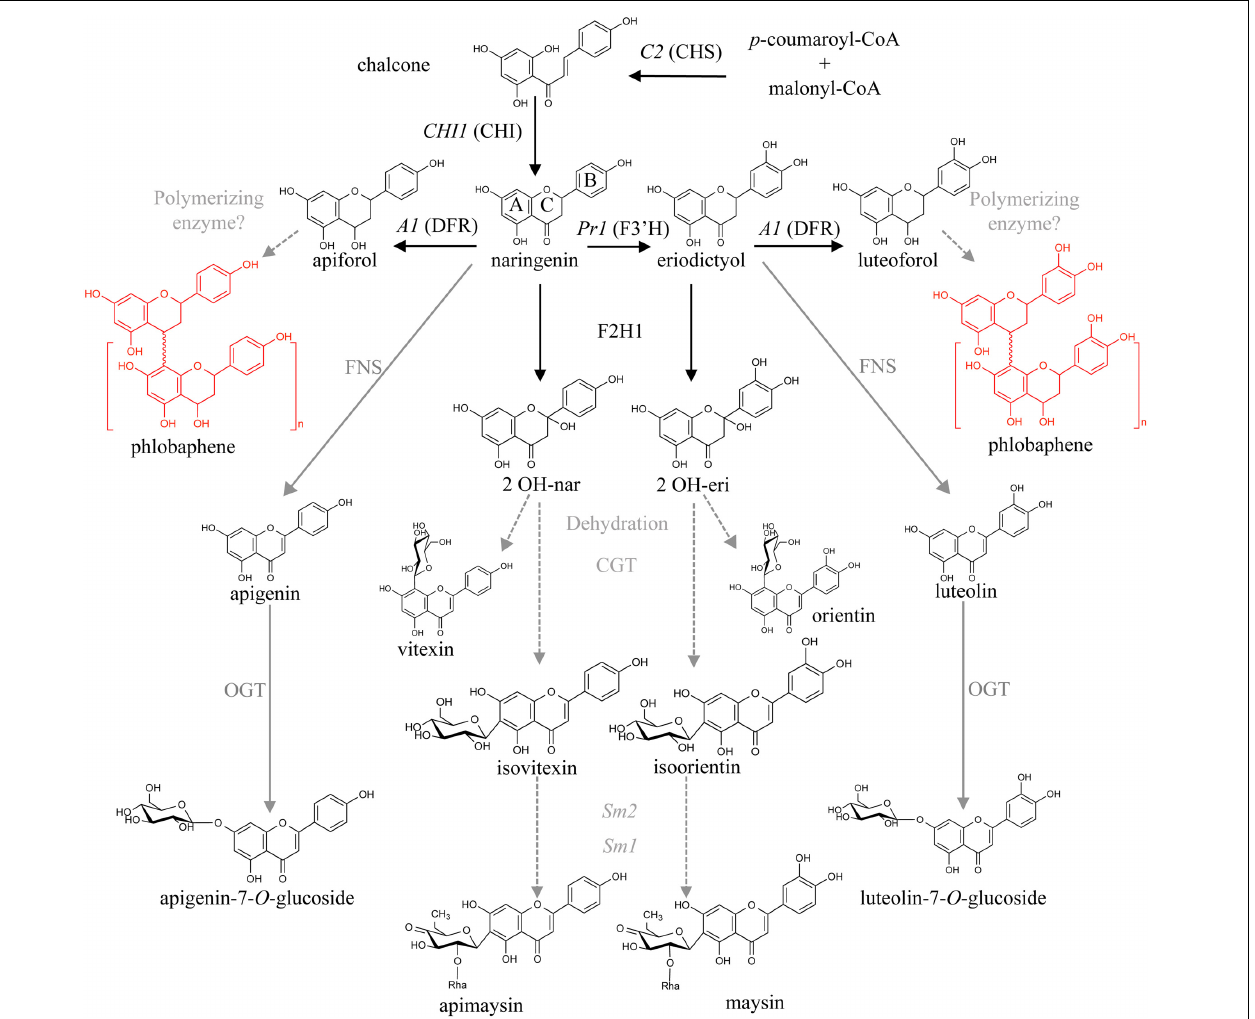
FIGURE 1 | Proposed maize flavone and 3-deoxy flavonoid biosynthetic pathways. Condensation of p -coumaroyl-CoA and malonyl-CoA by chalcone synthase (referred to as CHS, encoded by the locus C2 ) results in naringenin chalcone, which is then converted to naringenin by chalcone isomerase (CHI). Naringenin is converted to apiforol (flavan-4-ol) by a dihydroflavonol reductase (DFR, A1 ) and subsequently polymerized into phlobaphenes. It can also be converted to isovitexin ( C -glycosylflavone) by a flavanone-2-hydrohylase (F2H) and a C -glycosyl transferase (CGT). A